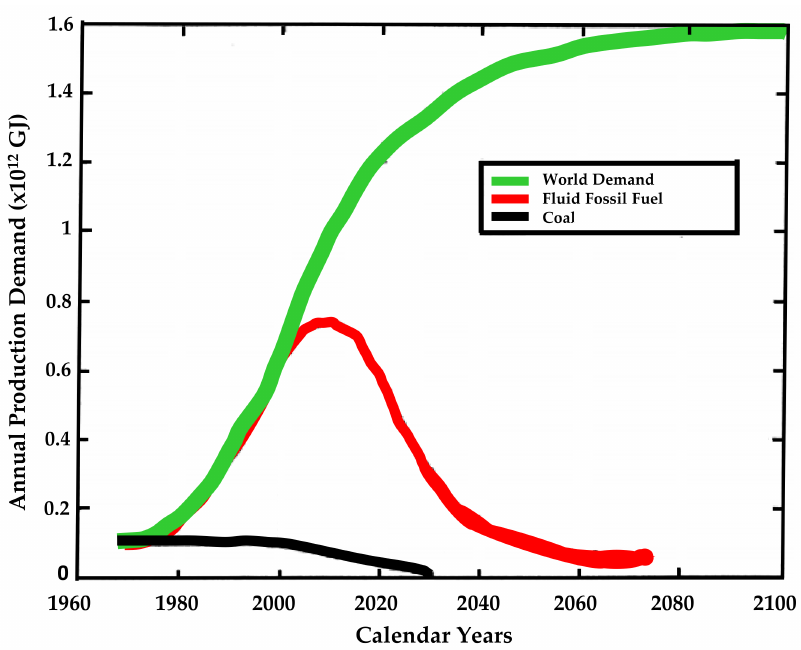
Figure 1. Estimated world production of fossil fuels. Adapted from Veziro˘glu and ¸Sahin